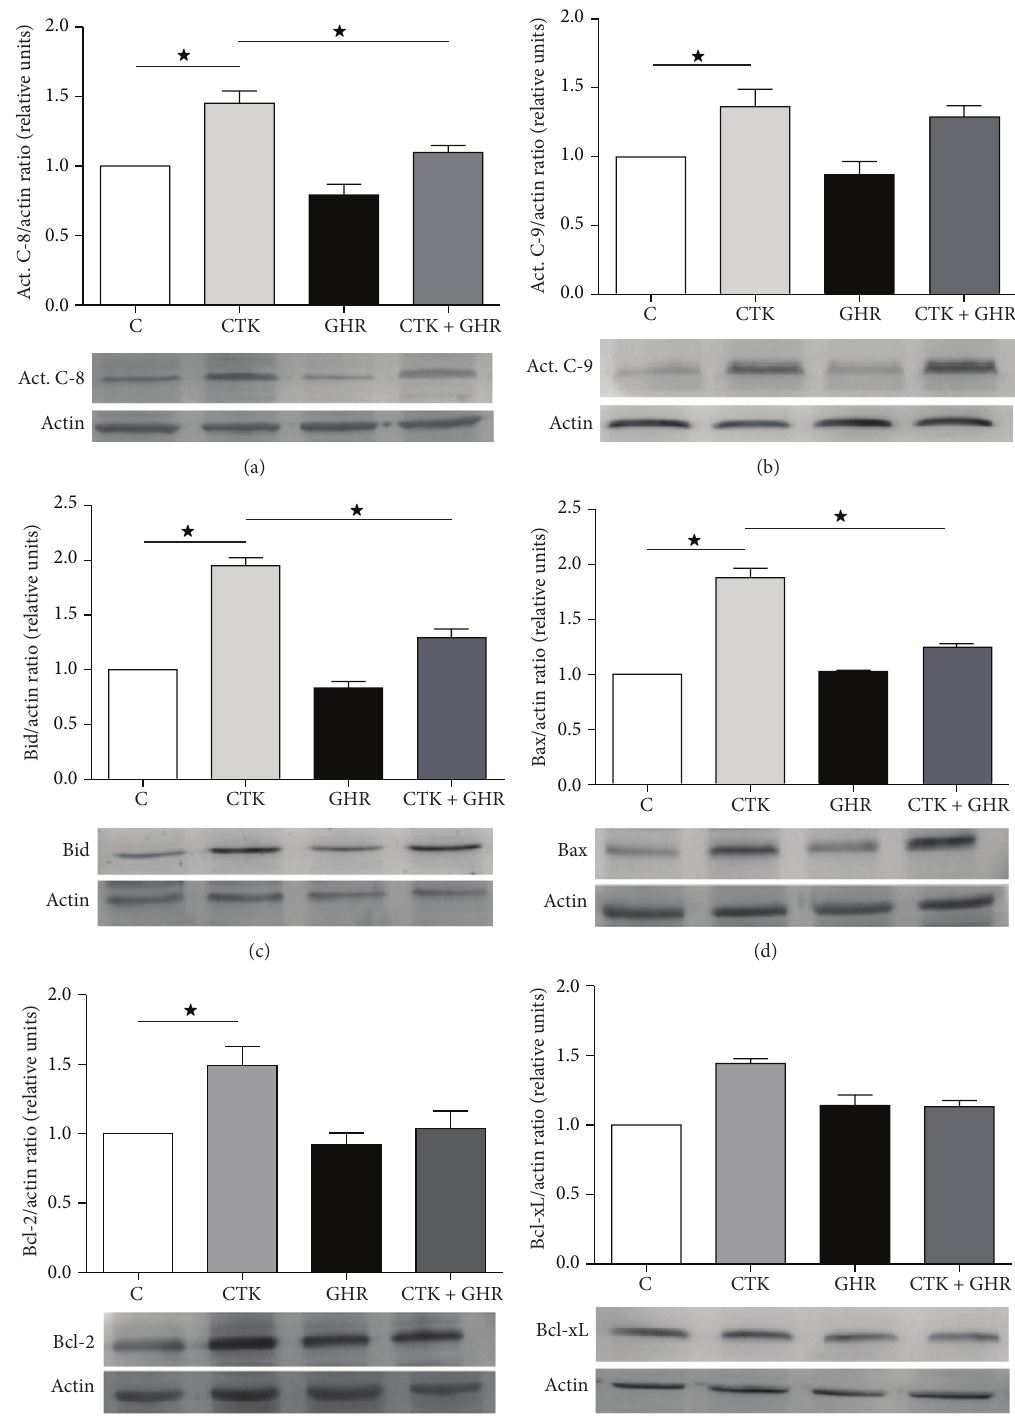
Figure 3: Ghrelin and cytokines’ effects on levels of caspases and Bcl-2 protein family members. Immunoblotting was performed to measure relative mean levels of active caspase-8 (a); active caspase-9 (b); BID (c); Bax (d); Bcl-2 (e); and Bcl-xL (f). Panels below the graphs show representative images of studied protein immunoblots. Results are presented as mean ± SEM of actin/studied protein ratio and referred to control cultures (c). Values were obtained from 4 independent experiments. * 𝑝 < 0.05 between groups. C, control; CTK, cytokines; GHR, ghrelin; CTK + GHR, cytokines +